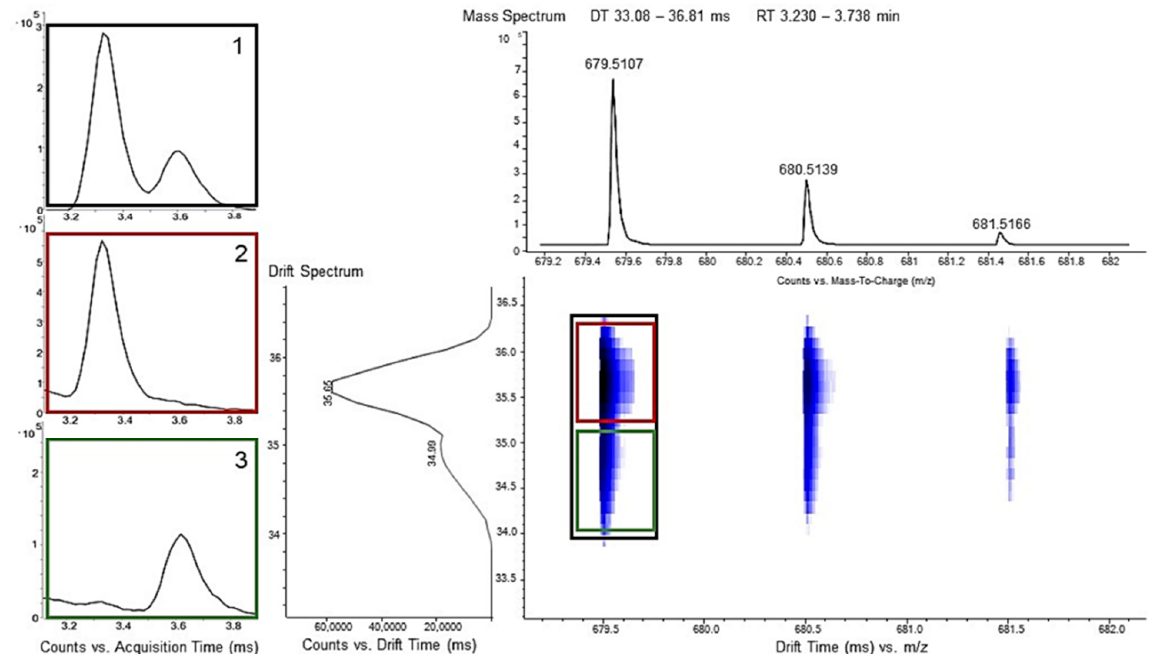
Figure 4. MS and DTIM data for the cyclic hexamer of a mixture of PA 6 and 6.6. At the exact mass of 679.511, a double peak in the drift spectrum can be observed, originating from the two different marker molecules, which vary only in the positioning of the functional groups. Extracted ion chromatogram of 1: drift time window of 33.1–36.8 ms, 2: drift time window of 35.0–36.8 ms, and 3: drift time window of 33.08–35.0 ms.